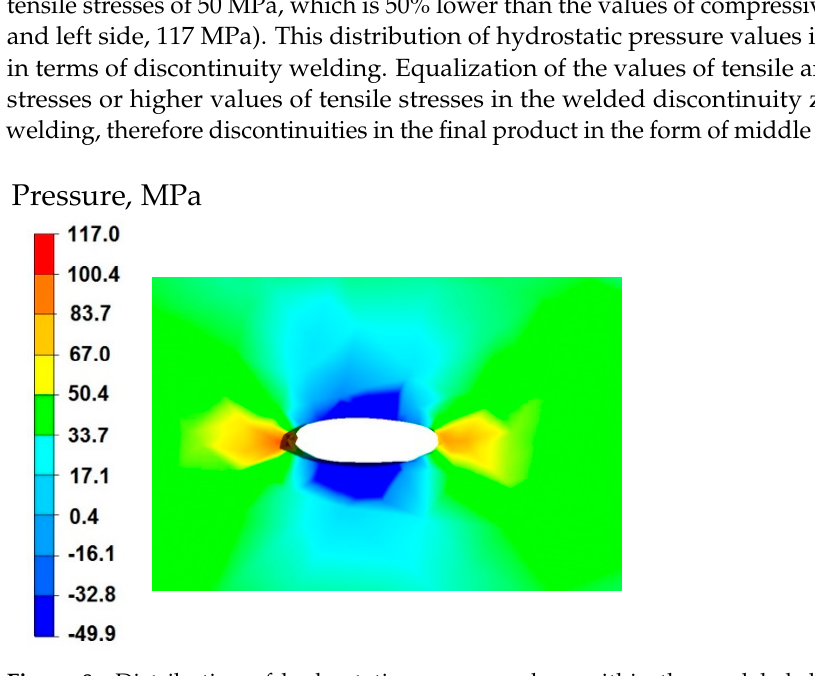
Figure 8. Distribution of hydrostatic pressure values within the modeled discontinuity at a 20% reduction.